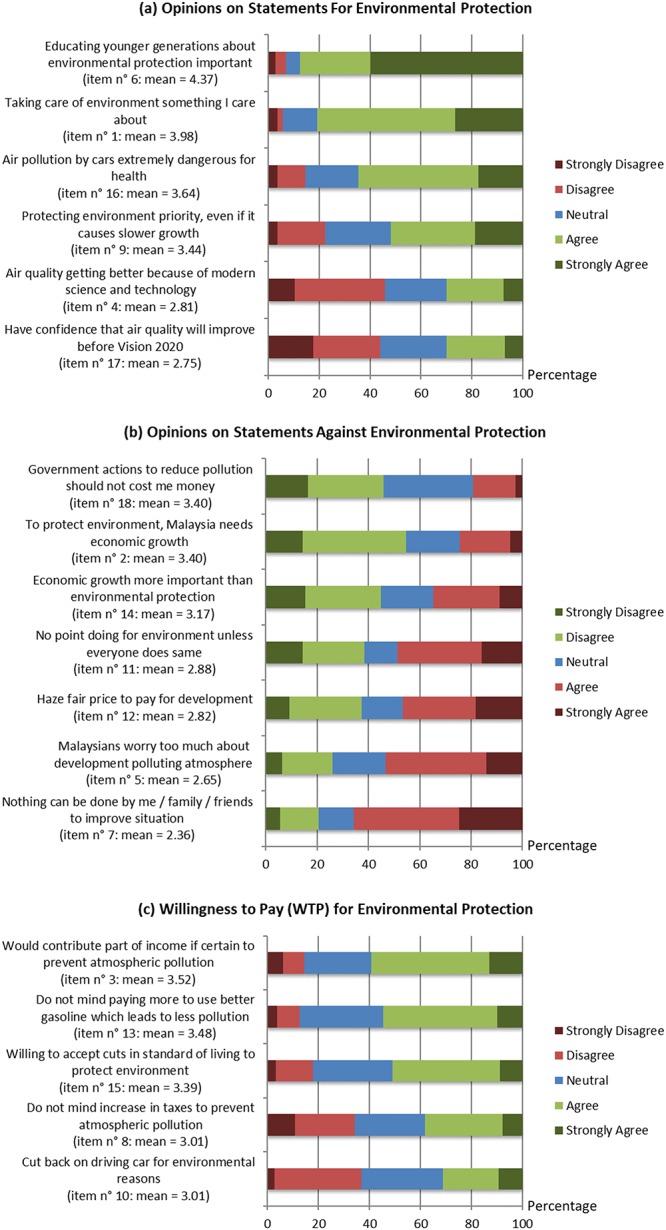
Opinions on statements pro environmental protection (a), statements against environmental protection (b), and statements on Willingness to Pay (WTP) for environmental protection (c).The proportion of participant responses for each question is shown in the chart. The statements against environmental protection (b) were reverse scored, with the strongly disagree response correlating with the highest pro-environmental opinion. Fig 5. Mean pro-environmental scores are shown next to each question on a scale of 1–5. Pro-environmental opinions are indicated by shades of green in all panels.